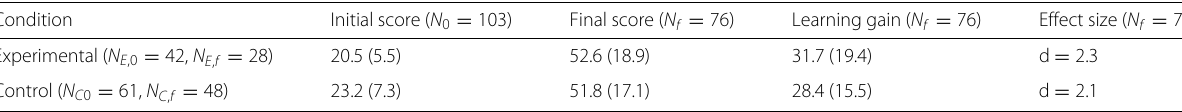
Table 3 Learning by time and tutoring dialogs ( R 2 = .54, R 2 Factor ( N = 76) Coefficient (raw) P value Log 10 (no. of hours in ALEKS) Log 10 (no. of AutoTutor dialogs interacted with) Intercept −